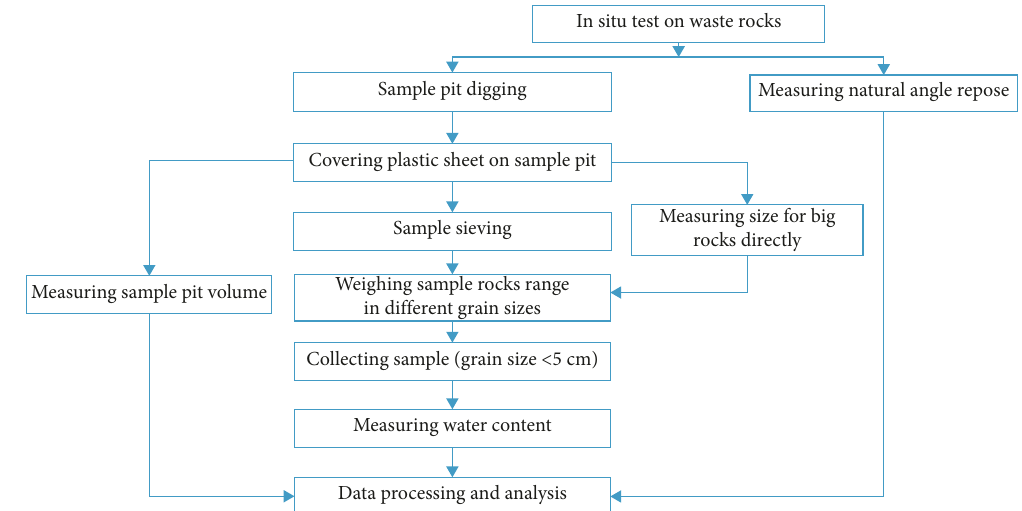
Figure 1: Flow chart of in situ tests on sample waste rocks.